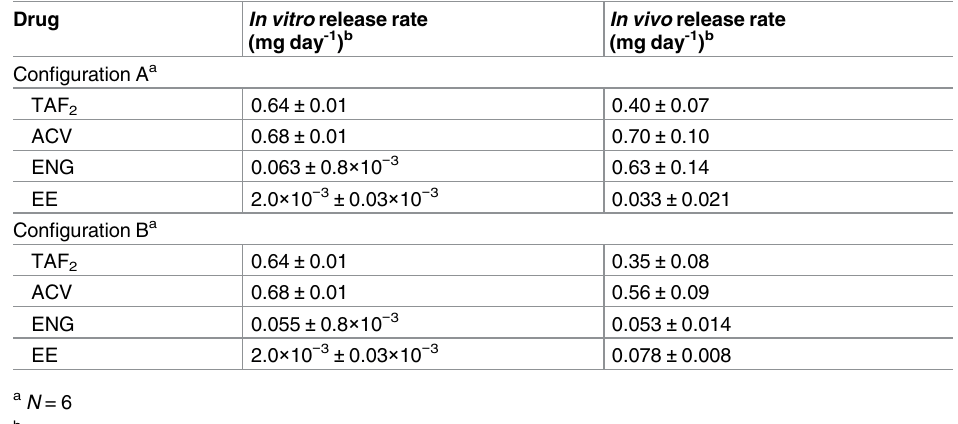
Table 3. In vitro and in vivo daily releaserates from Configuration A and Configuration B MPT pod-